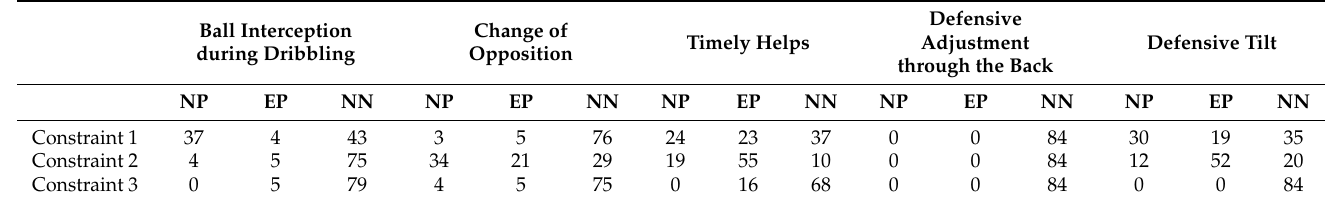
Table 3. Descriptive Analysis of observed Actions regarding Handball’s Motor Behaviors (b).